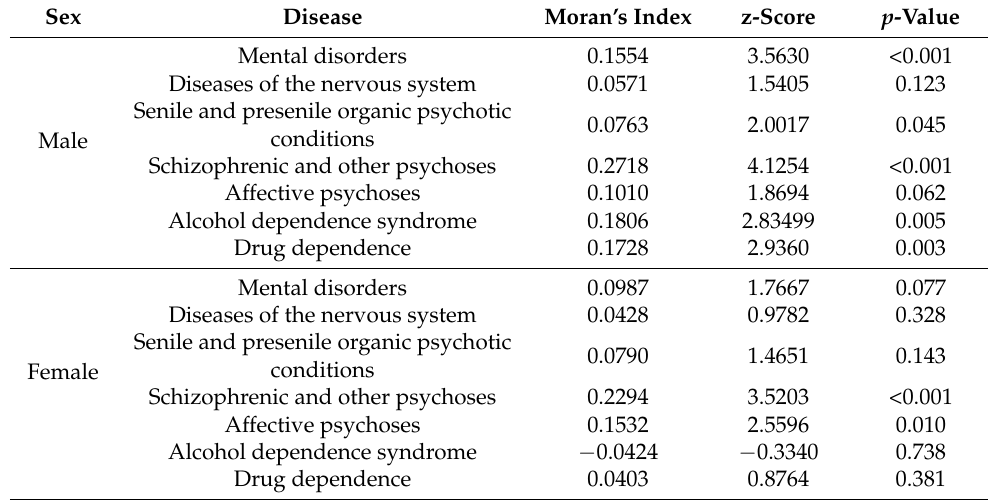
Figure 1. Descriptive ( a ), LISA ( b ) time series of annual PHR values ( c ) and average hospitalization-days ( d ) maps per sex for hospitalizations of patients with schizophrenia and other psychosis from 1999 to 2012 in Greece. Table 3. Spatial Autocorrelation Analysis.